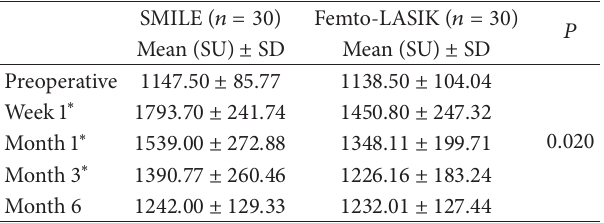
Table 2: Maximum backscattered light intensity in anterior stroma.